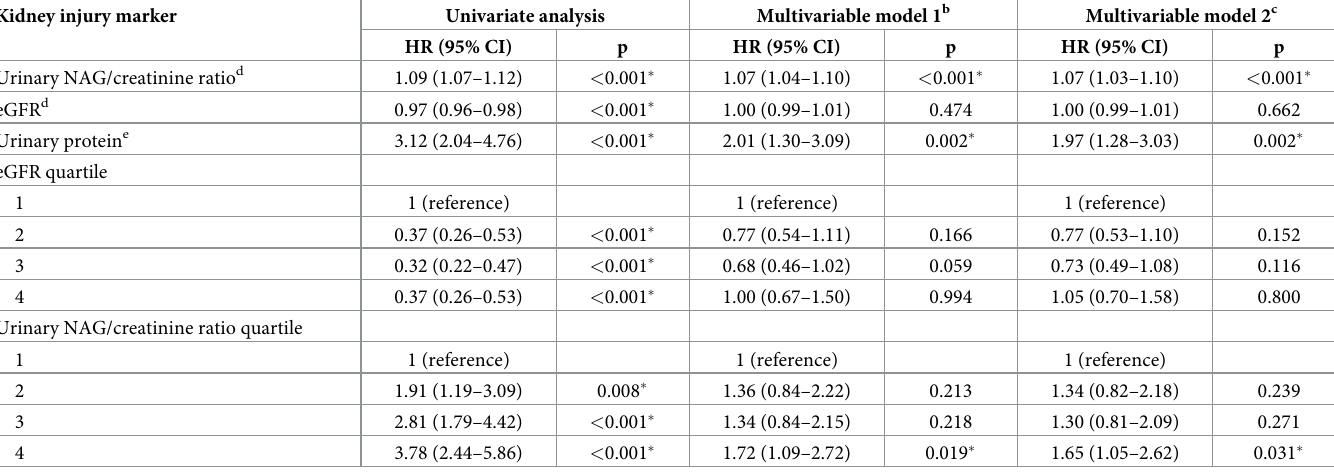
Table 5. Univariate and multivariable-adjusted hazard ratios (HRs) a for subsequent all-cause mortality, by kidney injury